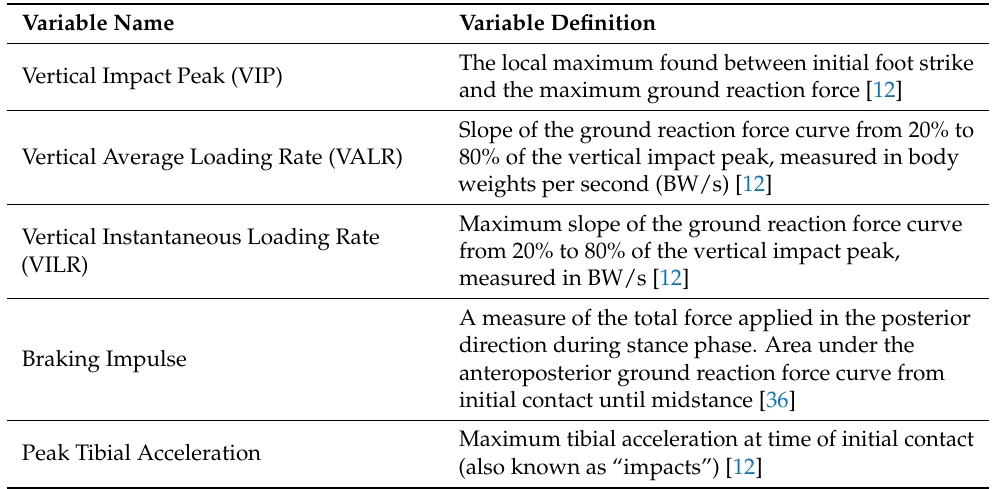
Table 1. Definitions of key biomechanical